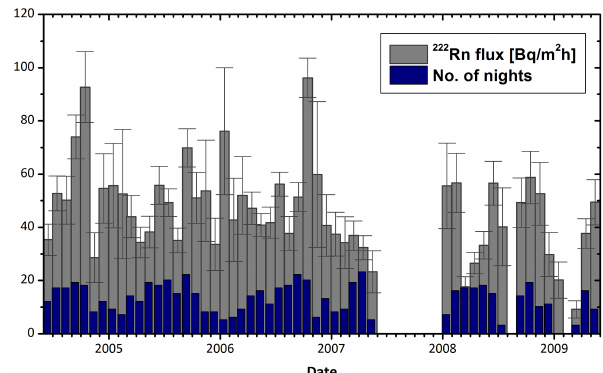
Figure 5. Monthly mean night-time fluxes of 222 Rn in the Krakow urban area for the period June 2004–May 2009, derived from atmo- spheric 222 Rn observations and sodar measurements of the mixing layer height (see text for details). Error bars indicate standard un- certainties of the mean values. Blue bars represent the number of nights used for calculation of the monthly